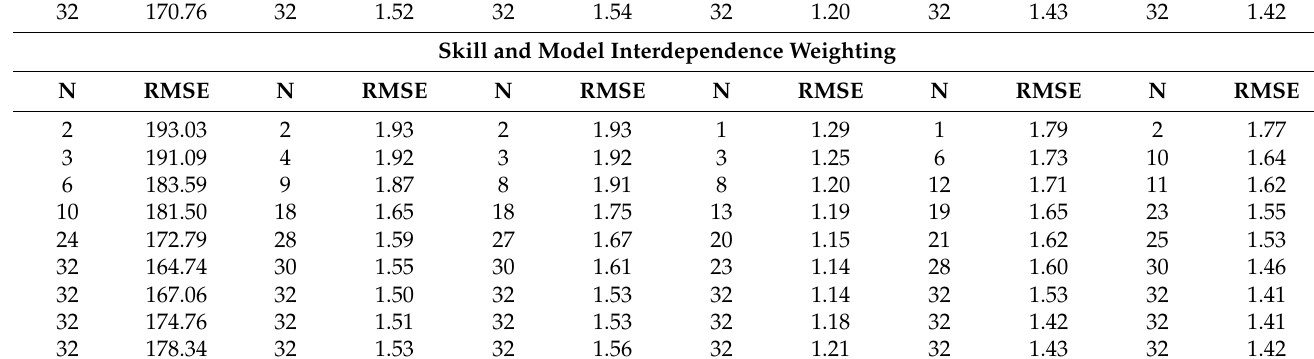
Viticulture climate classification directed LOCA CMIP5 model median skill values, δ , directly computed from the RMSE values listed in Table 3 and graphically repre- i ( obs ) sented in Figure 2, were ranked to develop ensemble compositions of size one to thirty-two. For each prediction of interest (i.e., GST, GDD, HI, CI, DI, and GMCC), the RMSE was subsequently computed for each of these thirty-two model compositions using simple model averaging (see Figure 5 for GST and Figures S1–S5 for GDD, HI, CI, DI, and GMCC, respectively). As previously mentioned, this simple method is like the approach presented by Yang et al. [25]; however, instead of the ranked skill scores from the Taylor diagram [28] we used the ranked model median